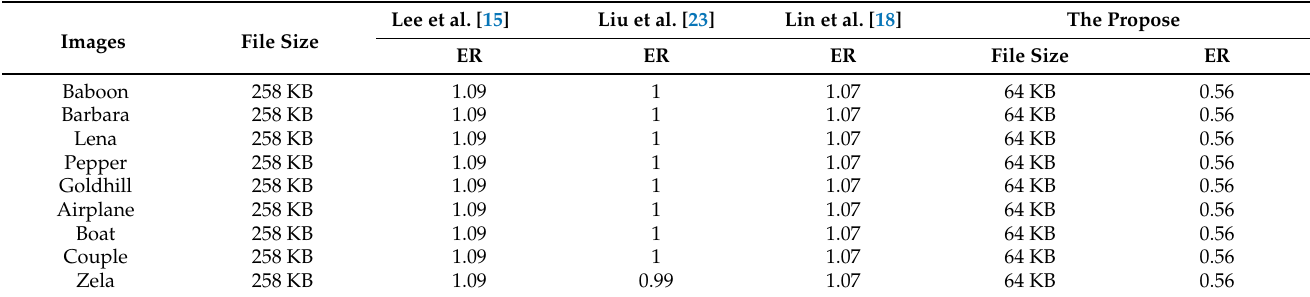
Table 4. Comparison of maximum embedding ratio with different